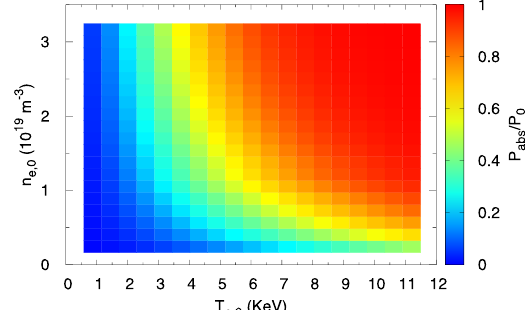
Fig. 4a. Absorption efficiency as a function of T e,0 , n e,0 (MID).